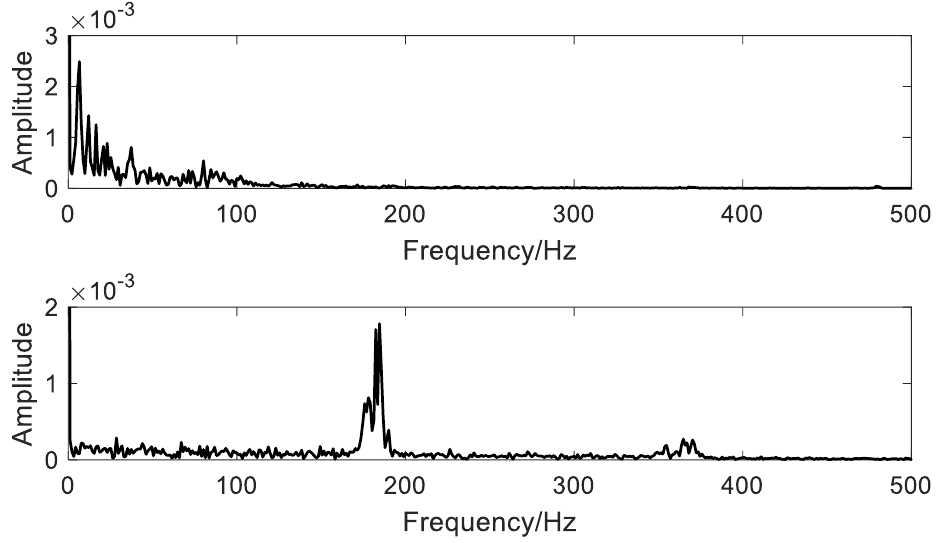
Figure 15. Spectra analysis of fifth component under F1 and F3.